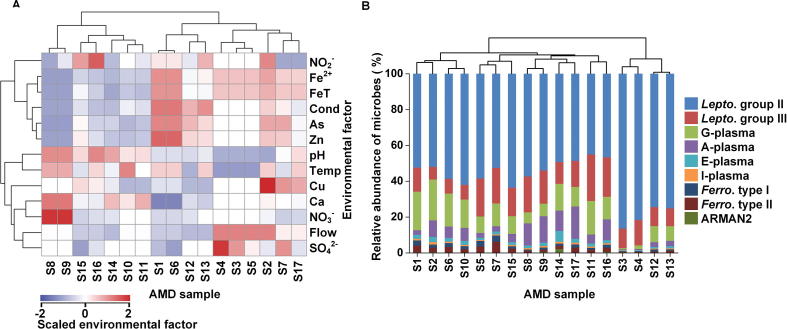
Hierarchical cluster analysis of AMD samplesA. Hierarchical cluster analysis of environmental factors of AMD samples. Environmental factors including solution discharge rate (Flow, l/min), pH, temperature (Temp, °C), electrical conductivity (Cond, mS/cm), and the concentrations of ferrous (Fe2+, M)/ferric and ferrous (FeT, M)/ copper (Cu, mM)/arsenic (As, mM)/zinc (Zn, mM)/calcium (Ca, mM)/ sulfate (SO42−, M)/nitrate (NO3−, nM)/nitrite (NO2−, nM) were standardized before hierarchical clustered. The standardized values of environmental factors are color-coded in the heatmap, with larger values in red and smaller values in blue. B. Hierarchical cluster analysis of microbial community composition of AMD samples. A-plasma, E-plasma, G-plasma, and I-plasma represent Thermoplasmatales archaeon A-plasma, E-plasma, G-plasma and I-plasma, respectively; Lepto. group II, Lepto. group III, Ferro. type I, and Ferro. type II indicate Leptospirillum group II, Leptospirillum group III, Ferroplasma type I, and Ferroplasma type II, respectively. ARMAN2 are from the archaeal Richmond Mine acidophilic nanoorganisms (ARMAN) lineages. The results show that 17 samples could be classified into two groups. The group (S3/S4/S12/S13) with higher percentage of Leptospirillum group II is in the early developmental stage and the other group is in the late succession stage. AMD, acid mine drainage.